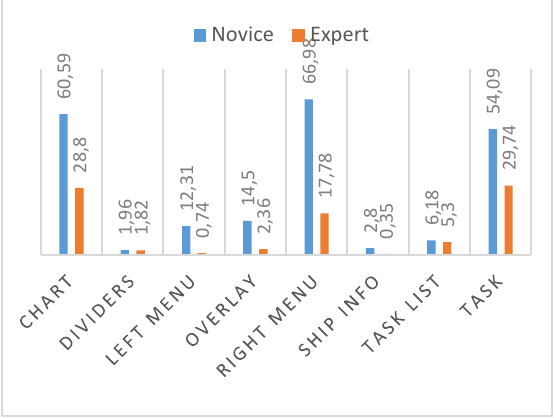
Figure 4. Comparison of means of total fixation duration measurements of novice and expert participants on ecdis.